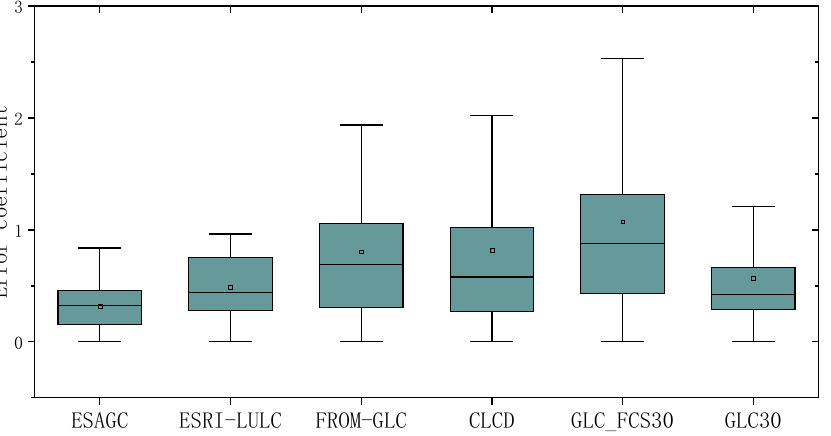
Figure 5. Scatter plots showing a comparison of the forest area at the municipal level in Guangxi between the six land cover data sets and the statistical yearbook data.